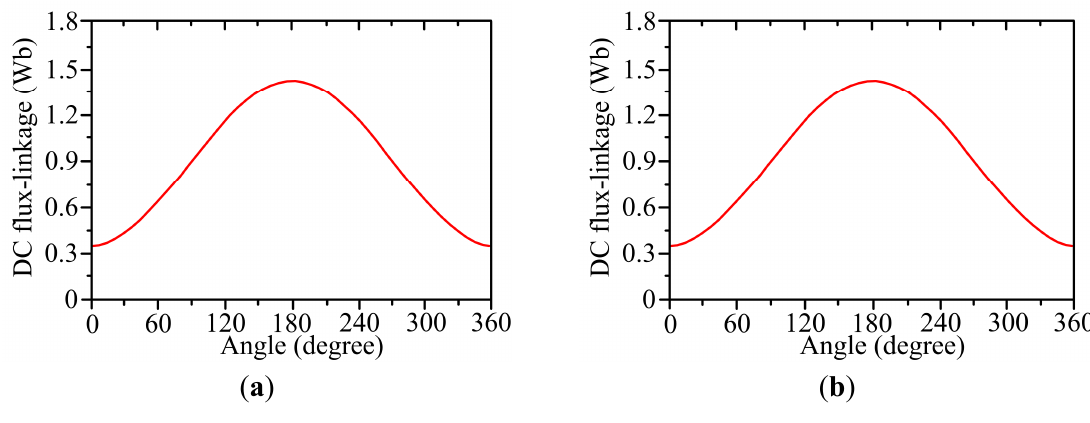
Figure 9. Self-inductance waveforms: ( a ) Winding 1; and ( b ) Winding 2.